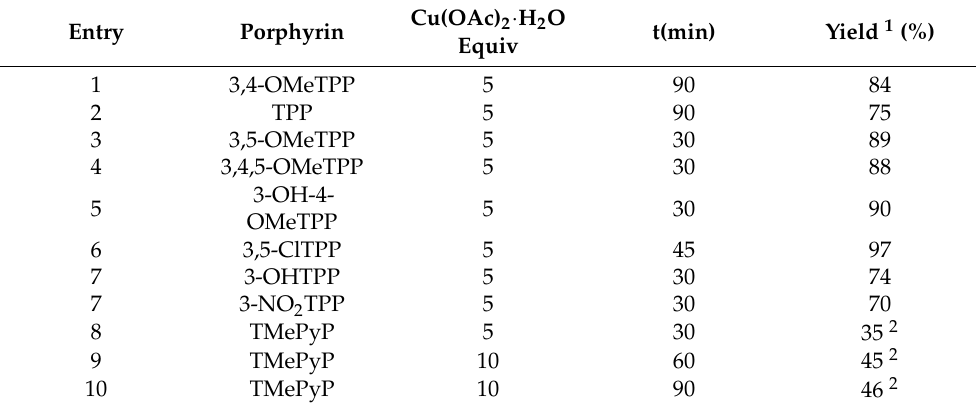
Table 2. Synthesis of copper complexes of meso -substituted porphyrins under mechanical action (milling frequency 30